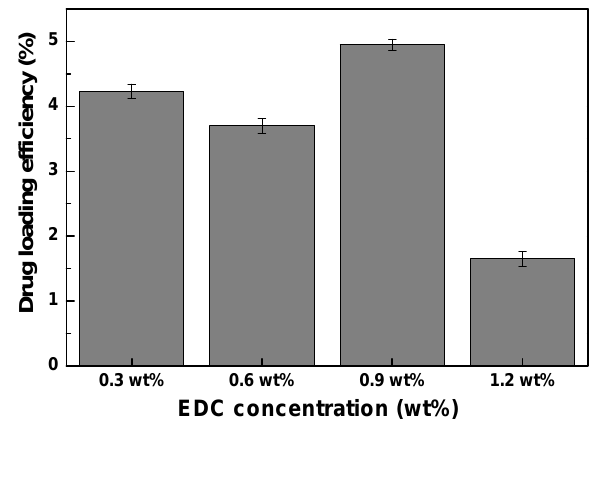
Figure 9. Drug-loading efficiency of the chitosan-MnFe drug mixed with the MNPs that were effectively released. Error bars represent the standard deviation for three